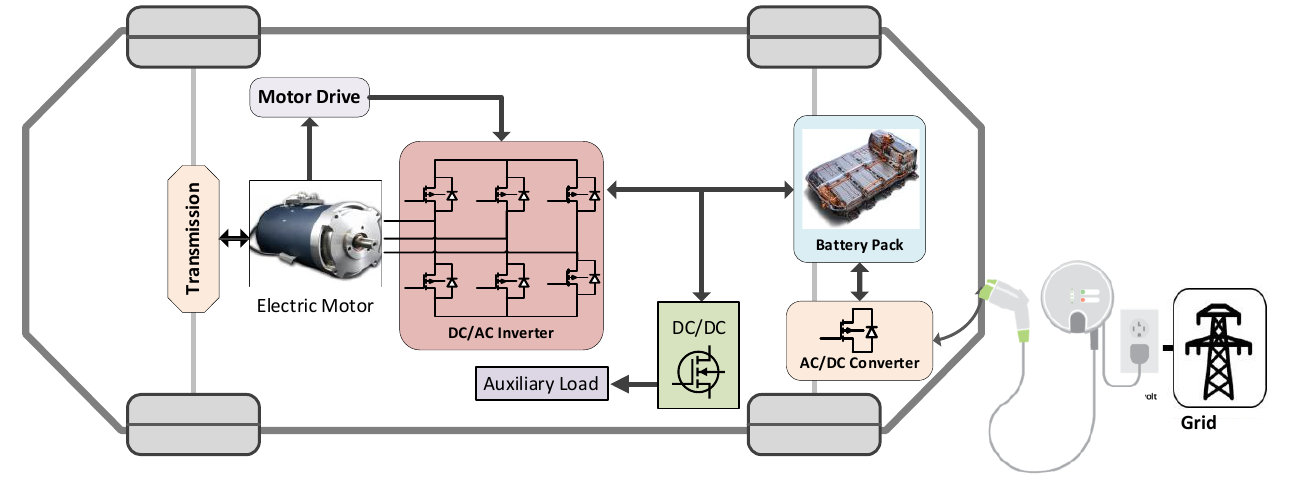
Figure 1. Four-wheel electric drive vehicles.